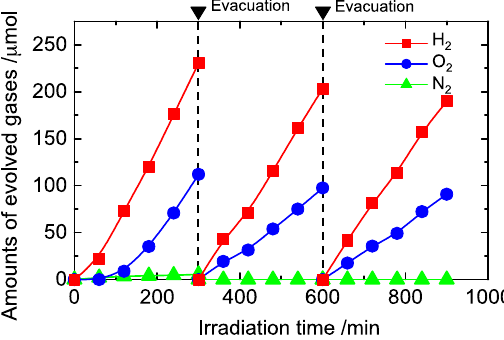
Figure 7. Time course for water splitting on Pt (0.2 wt. %)/Dye 2 (0.8 wt. %)/KTa(Zr)O 3 .